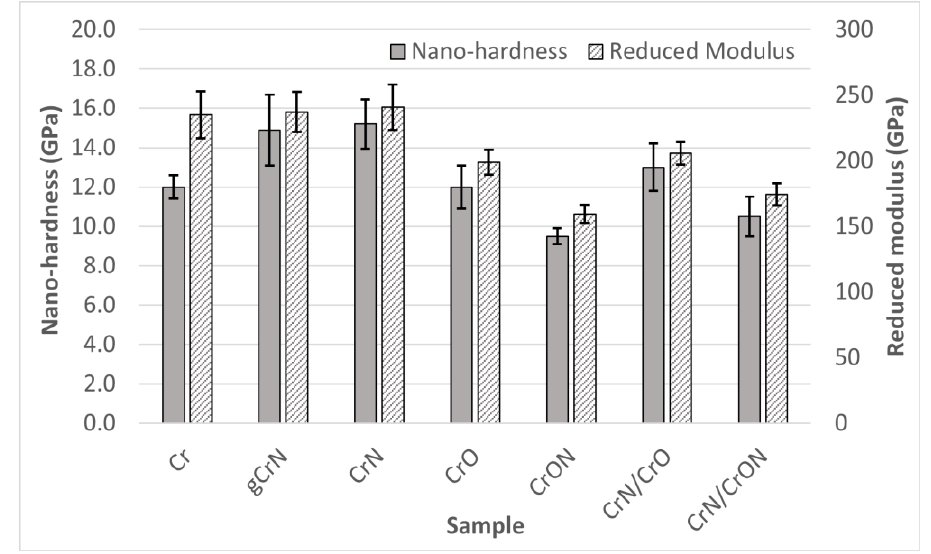
Figure 8. Nano- hardness and Young’s modulus of the coatings deposited onto